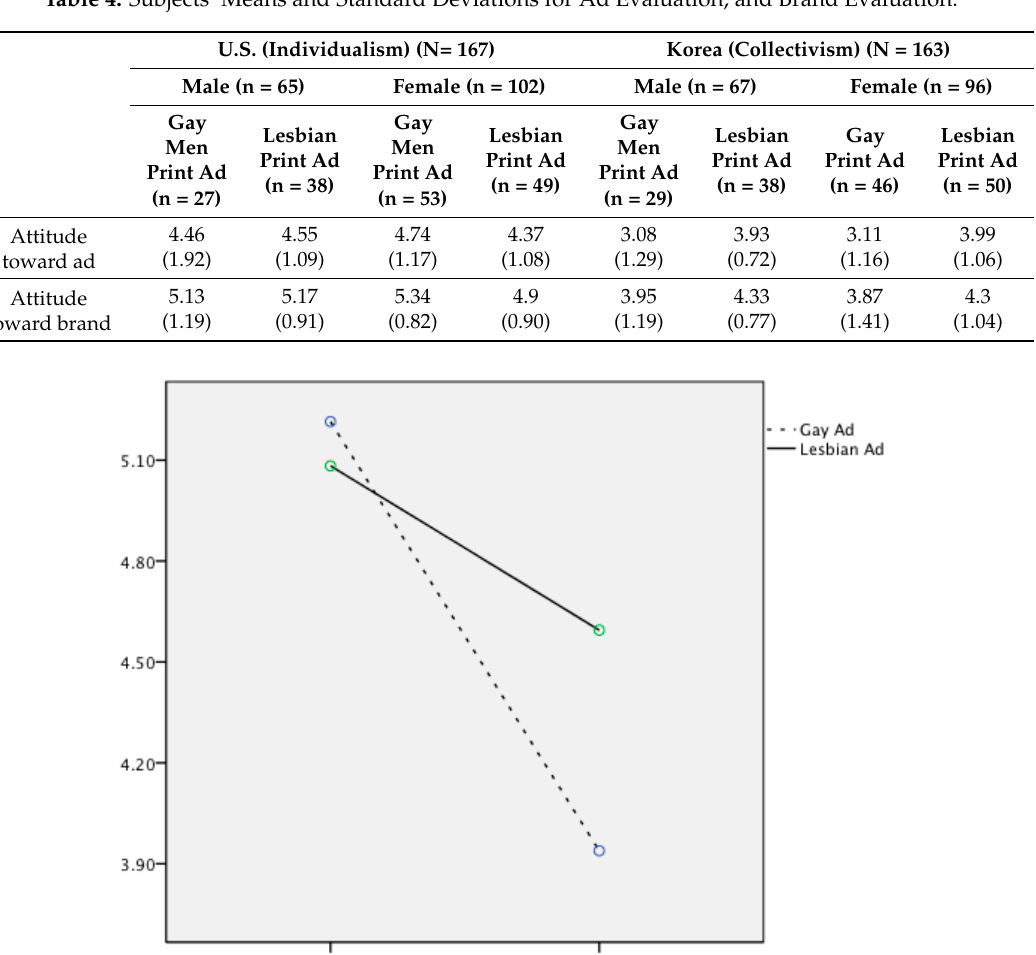
Figure 2. Interaction between cultural orientation and ad type on brand